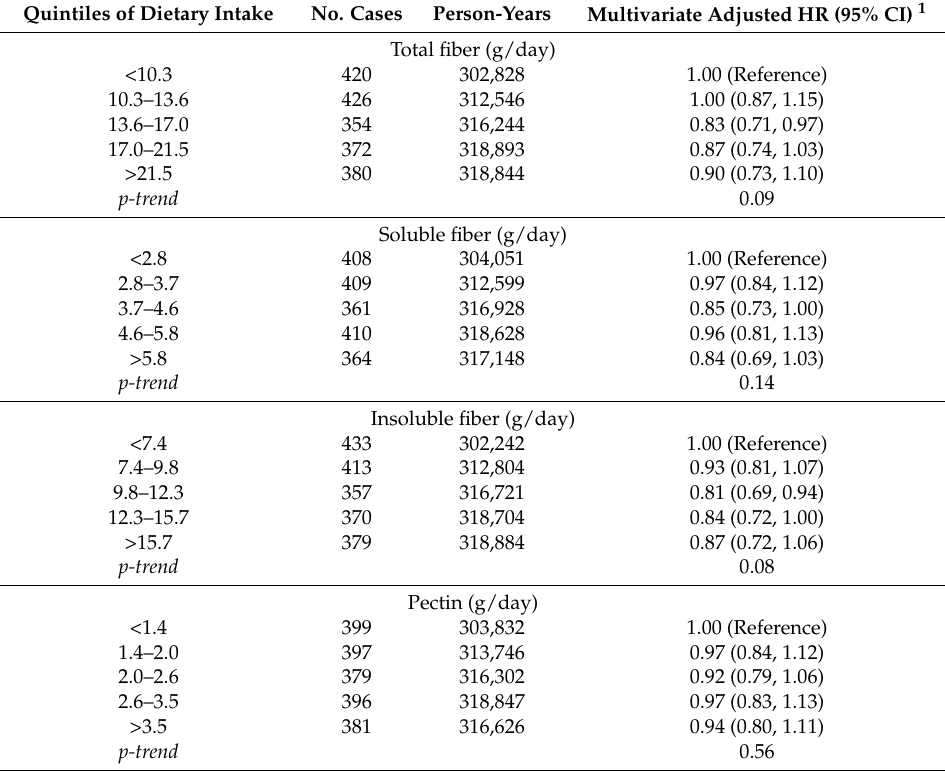
Table 2. Multivariate-adjusted hazard ratios and 95% CIs for the association of fiber with colorectal cancer in the Women’s Health Initiative ( n = 134,017)